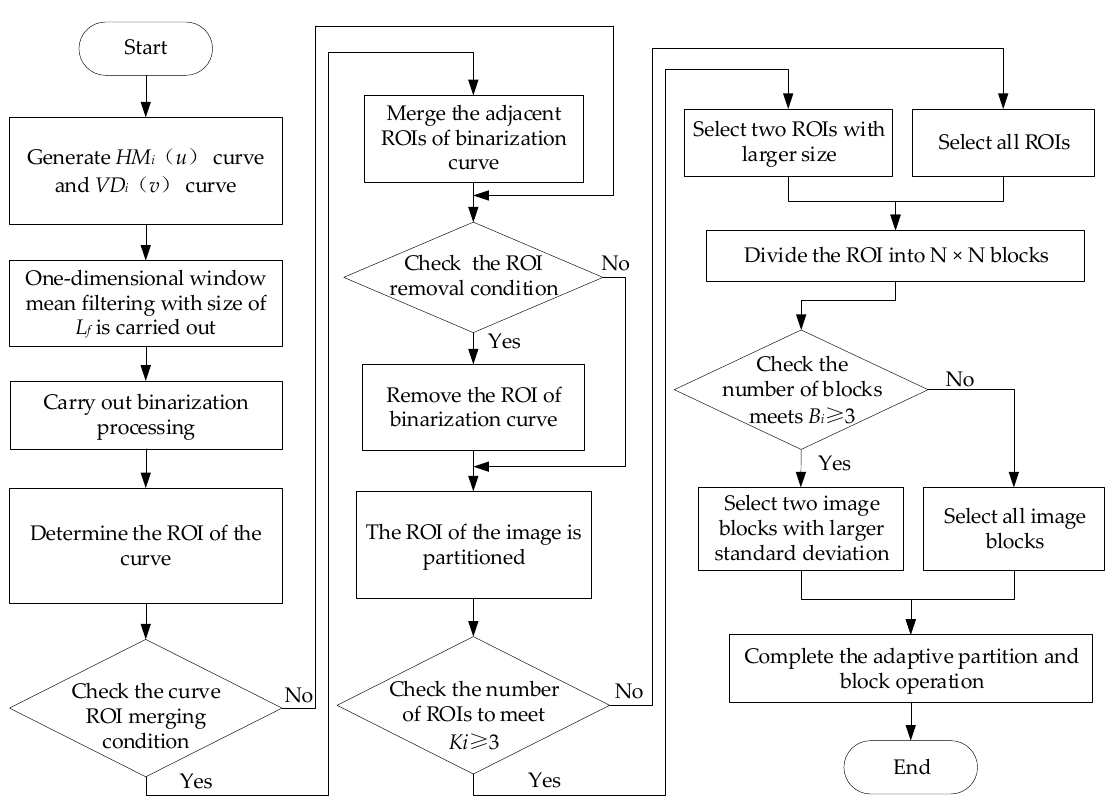
Figure 7. Flow chart of adaptive partition and block operation for the image of interest (IOI). We verify the effect of partition operation for the IOI. An IOI with a size of 2048 × 2048 (assuming that the whole image is an overlapping region), as shown in Figure 8a, is partitioned. The curves of HM 1 ( u ) and its mean, VD 1 ( v ) and its mean are shown in Figure 8c,d. Construct a one-dimensional window template of size 61 ( L f = 61) for mean filtering. The curves of HM′ 1 ( u ) and its mean are shown in Figure 8e. The curves of VD′ 1 ( v ) and its mean are shown in Figure 8f.The binarization curves B HM1 ( u ) and B VD1 ( v ) are obtained as shown in Figure 8g,h, respectively. Suppose T C = 128 and T B = 128, the binarization curves B HM1 ′ ( u ) and B VD1 ′ ( v ) obtained after merging and removing operations are shown in Fig- ures 8i,j, respectively. Finally, the ROI is partitioned, and the result is shown in Figure 8b. It can be seen from 8b that most of the defect information of the conveyor belt is con- tained in the ROI, which reduces the scope of image registration. ( a )